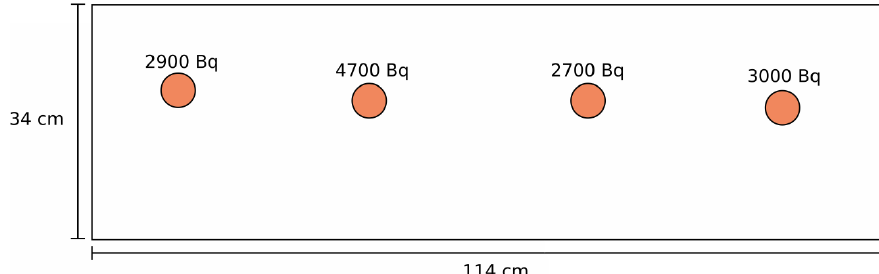
Figure A2. A schematic diagram showing the physical locations of the sources used for scenario 2.